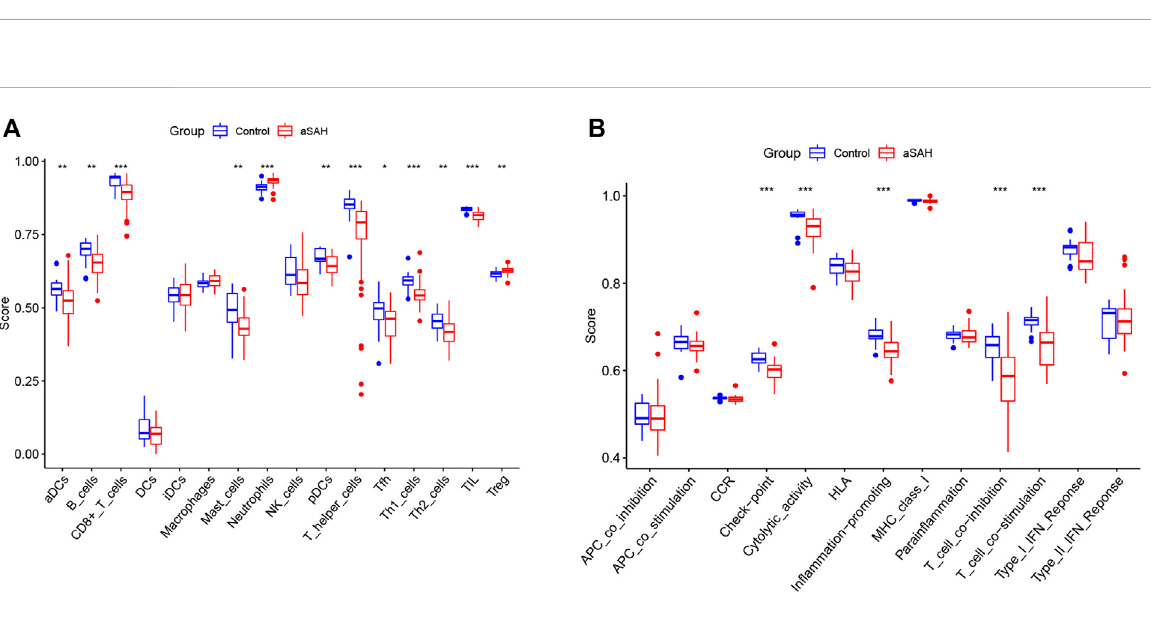
FIGURE 11 Boxplot of differential immune cells (A) and immune features (B) between control and aSAH group in GSE36791; * p < 0.05; ** p < 0.01; *** p <